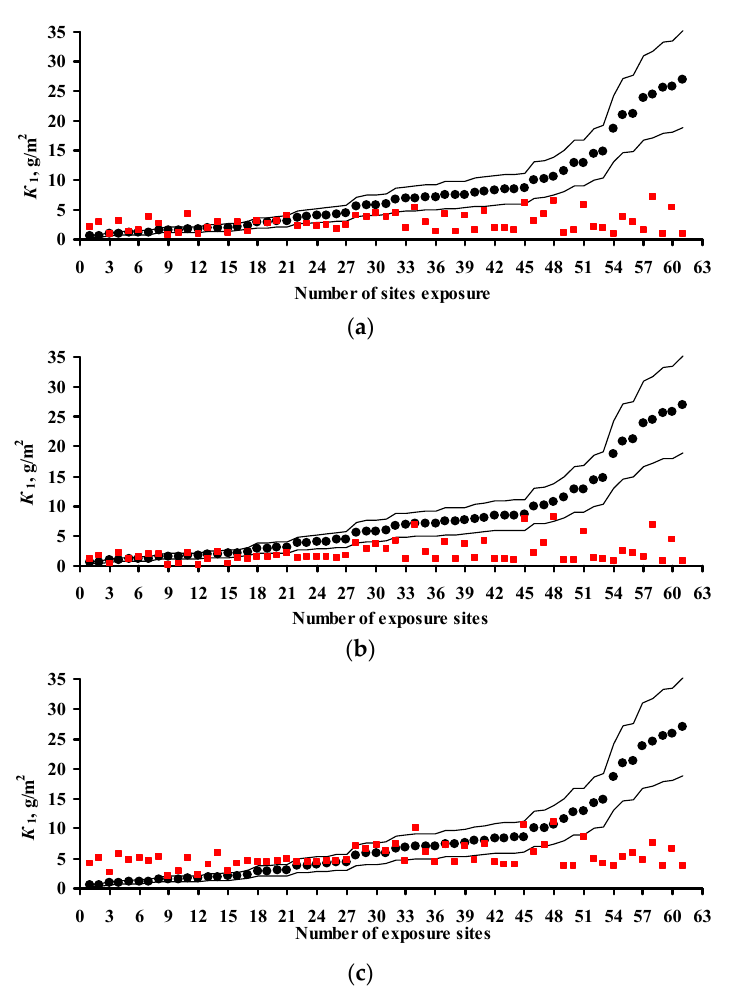
Figure 9. Zinc. MICAT program. K 1 predictions by the New DRF ( а ); Standard DRF ( b ); and Unified DRF ( c ). ● —experimental K 1 data; ■ — K 1 predictions. Thin lines show the calculation error (± 30%). The numbers of the exposure sites are given in accordance with Table 3.